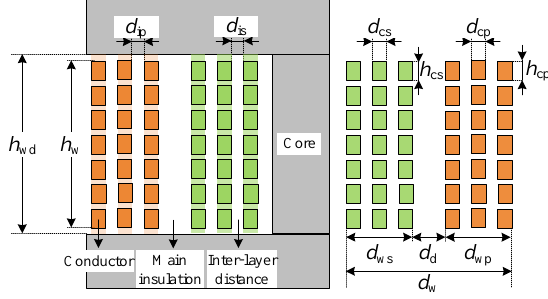
Figure 8. Winding parameters.